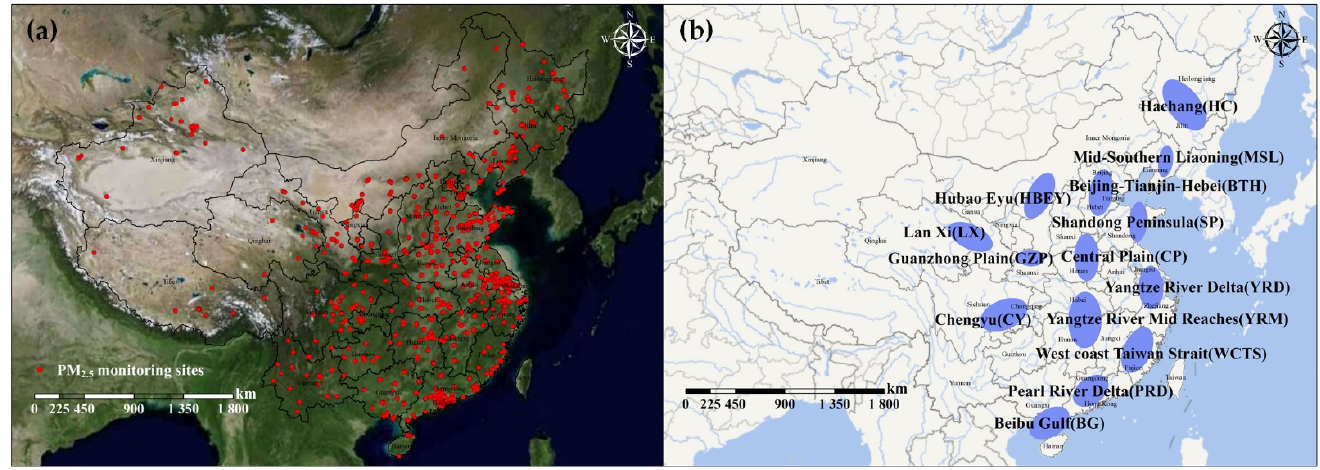
Figure 1. Study area: ( a ) the 1523 monitoring sites for surface air quality and ( b ) the fourteen urban agglomerations in China [29].